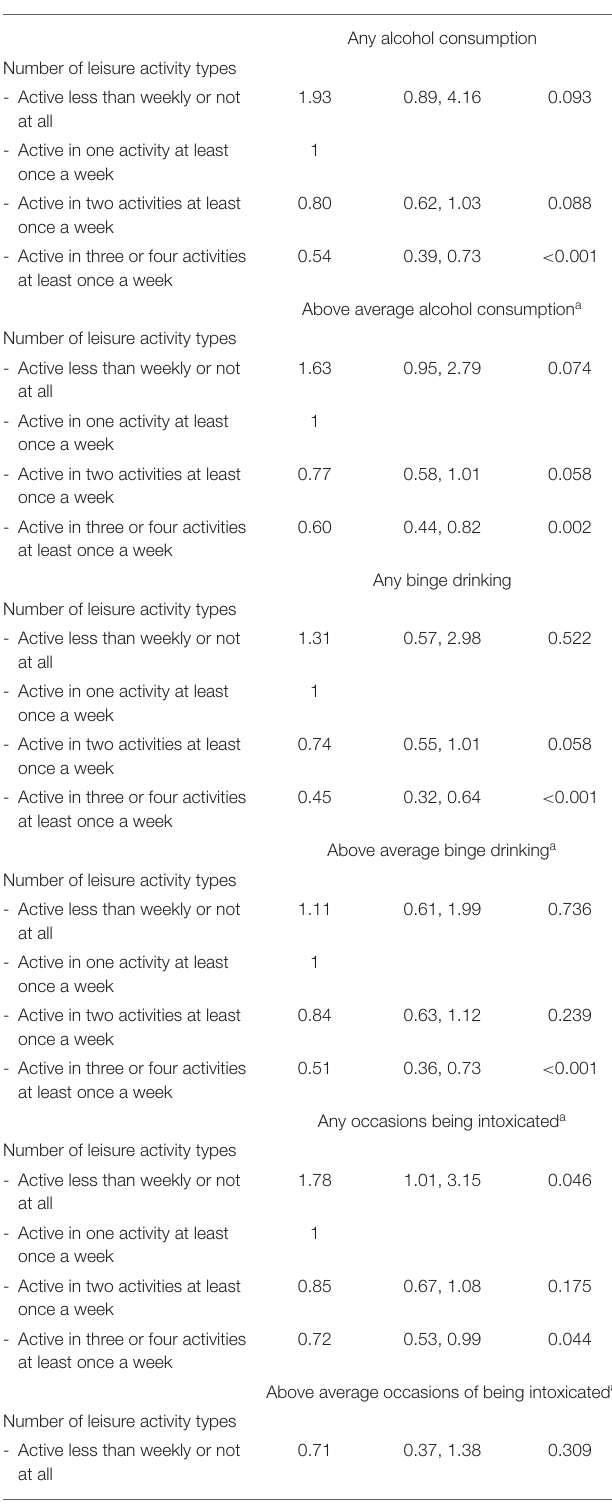
TABLE 5 | The association between number of leisure activity types and alcohol use estimated by multivariable logistic regression. OR 95%